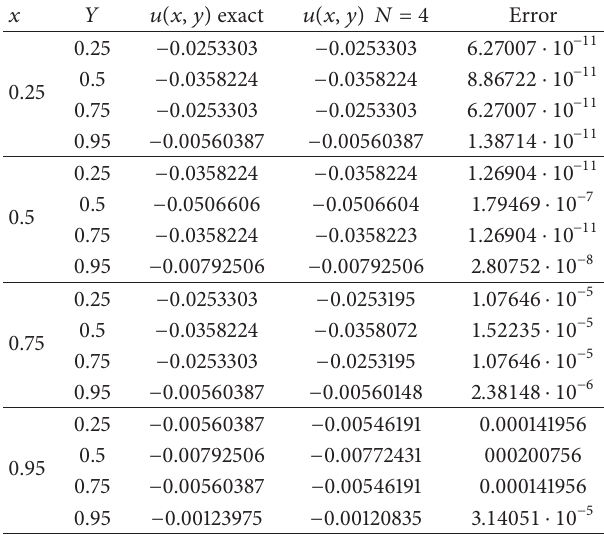
Table 1: Evaluation of numerical errors for 𝑁 = 4 .